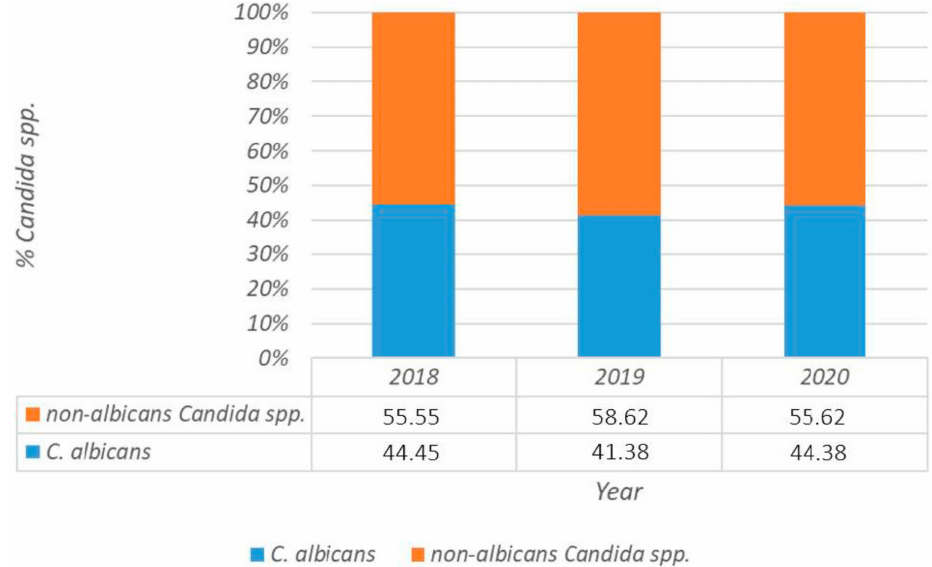
Figure 1. Proportion rate of C. albicans and non- albicans Candida species during the three-year study period. The results of susceptibility testing of the three most frequently isolated Candida spp. to antifungal agents are shown in Table 5. Susceptibility dose-dependent or resistance to fluconazole was detected in 52 (51.49%) of the isolates, mainly in C. parapsilosis and C. glabrata . Resistance to the three echinocandins was found in six C. albicans isolates and one